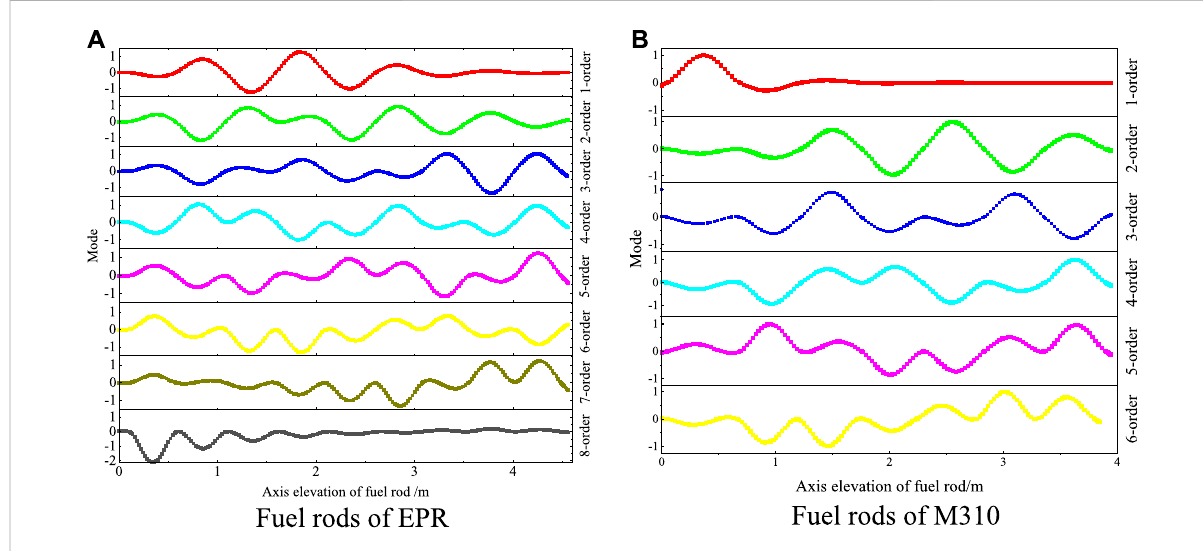
FIGURE 7 Vibration modes on X-Y plane. (A) : EPR fuel rod vibration modes on X-Y plane. (B) : M310 fuel rod vibration modes on X-Y plane.